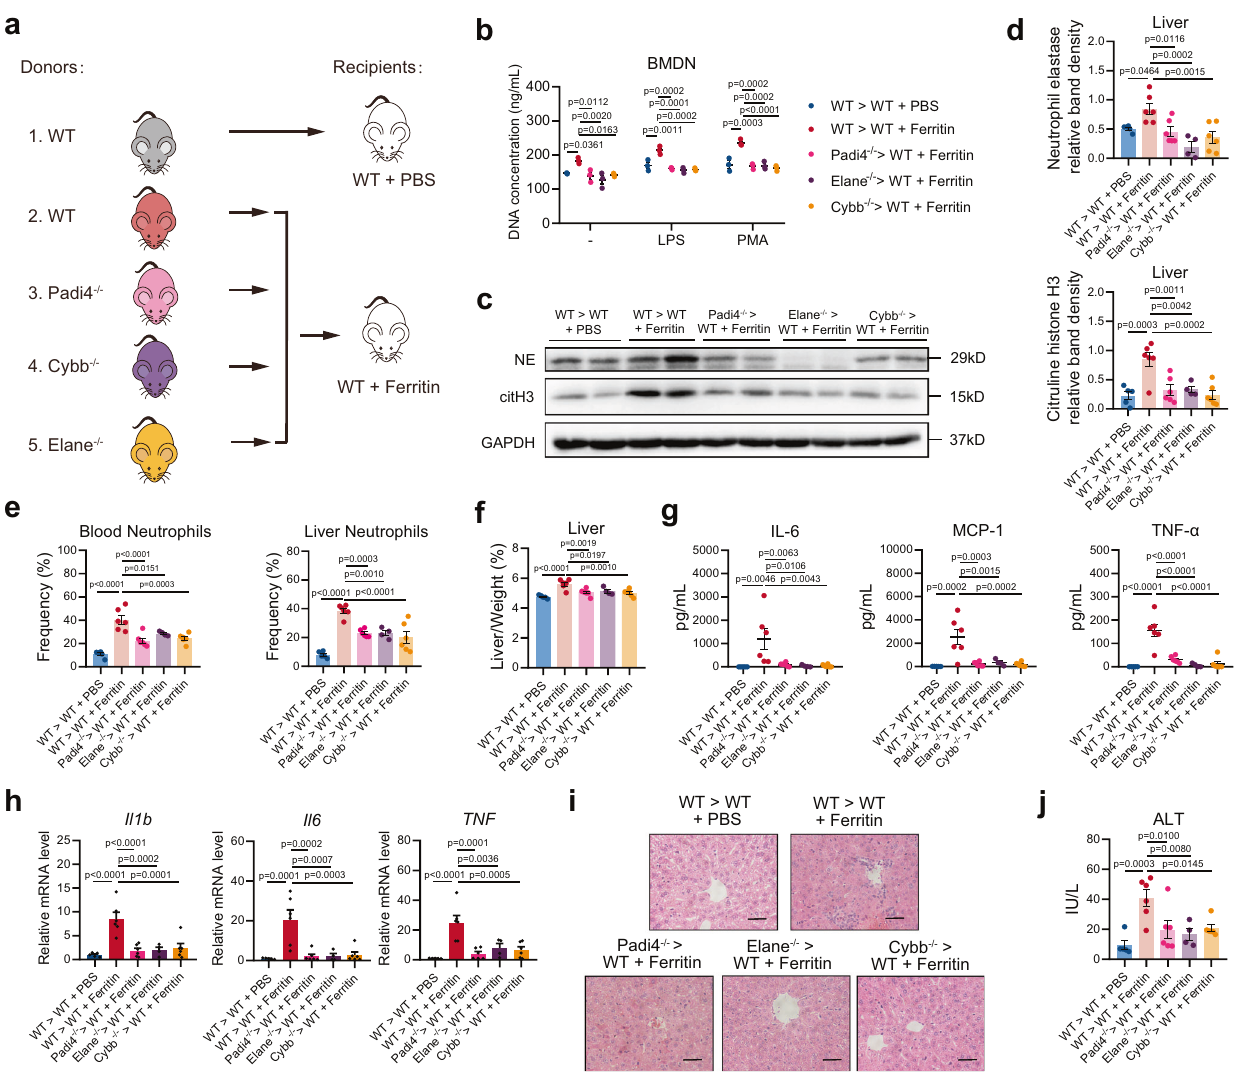
Fig. 5 | Genetic disruption of PAD4, NE and ROS in BM improves ferritin- induced in fl ammation. a Experimental overview: Bone marrow (BM) from WT, Padi4 − / − , Elane − / − and Cybb − / − mice in C57BL6 background were transplanted to WT recipients and allowed to reconstitute for 4 weeks following which ferritin was injected. b Quanti fi cation of cell-free DNA released by BMDNs ( n =3). c , d Western blotting analysis for NET markers citH3 and NE in the livers (WT>WT+PBS: n =5, WT>WT+Ferritin: n =6,Padi4 − / − >WT+Ferritin: n =6,Elane − / − >WT+Ferritin: n =4, Cybb − / − >WT+Ferritin: n =6). Representative Western blotting was shown. e – g Peripheral blood and liver neutrophil ( e ), changes of liver to body weight ratio ( f )